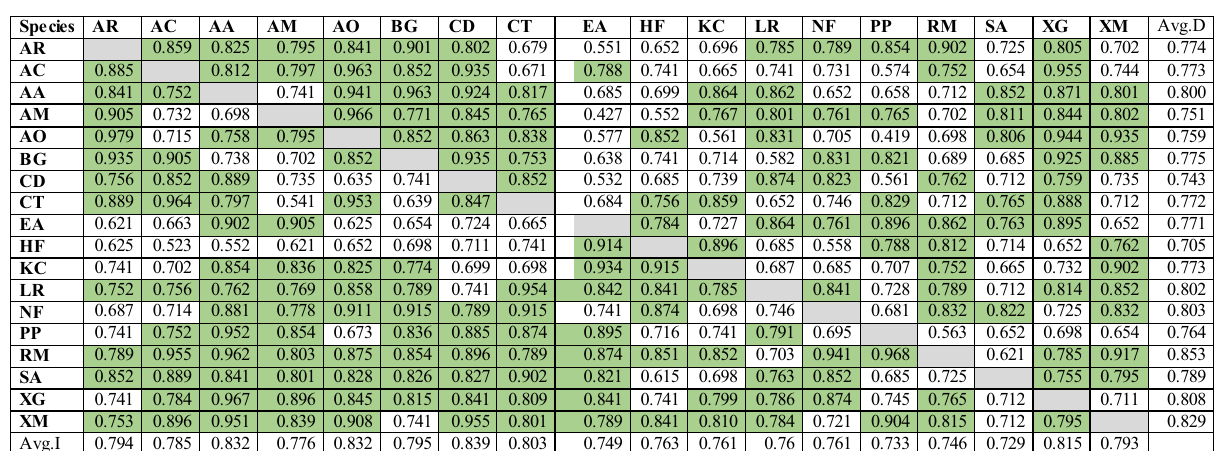
Figure 8. Habitat suitability maps for the selected 18 true mangrove species in the Sundarban Biosphere Reserve The maps were prepared using ArcGIS 10.8.2 software [https:// deskt op. arcgis. com].)